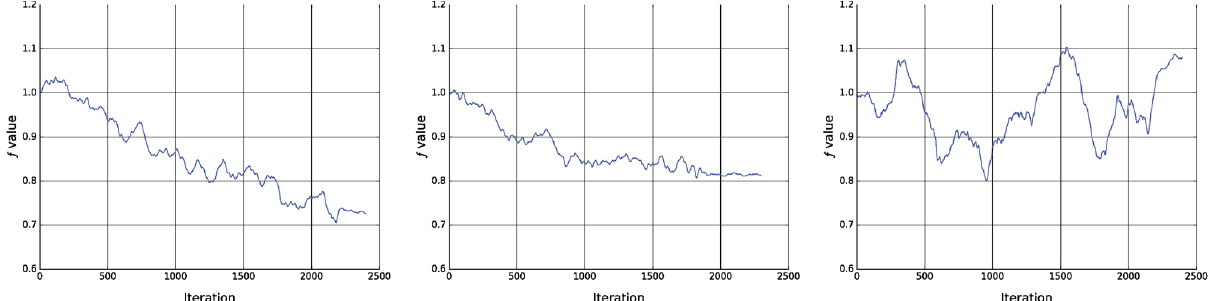
Fig. 6 Fluctuation of f during training in the general image parsing task, using the same initial network settings. Only changes in the first 2500 iterations are plotted here. The initial dilation value was 4, much smaller than the optimal value. In this case, f sometimes may become trapped in local minima and stay near 1. Small initial dilation values are to be avoided.